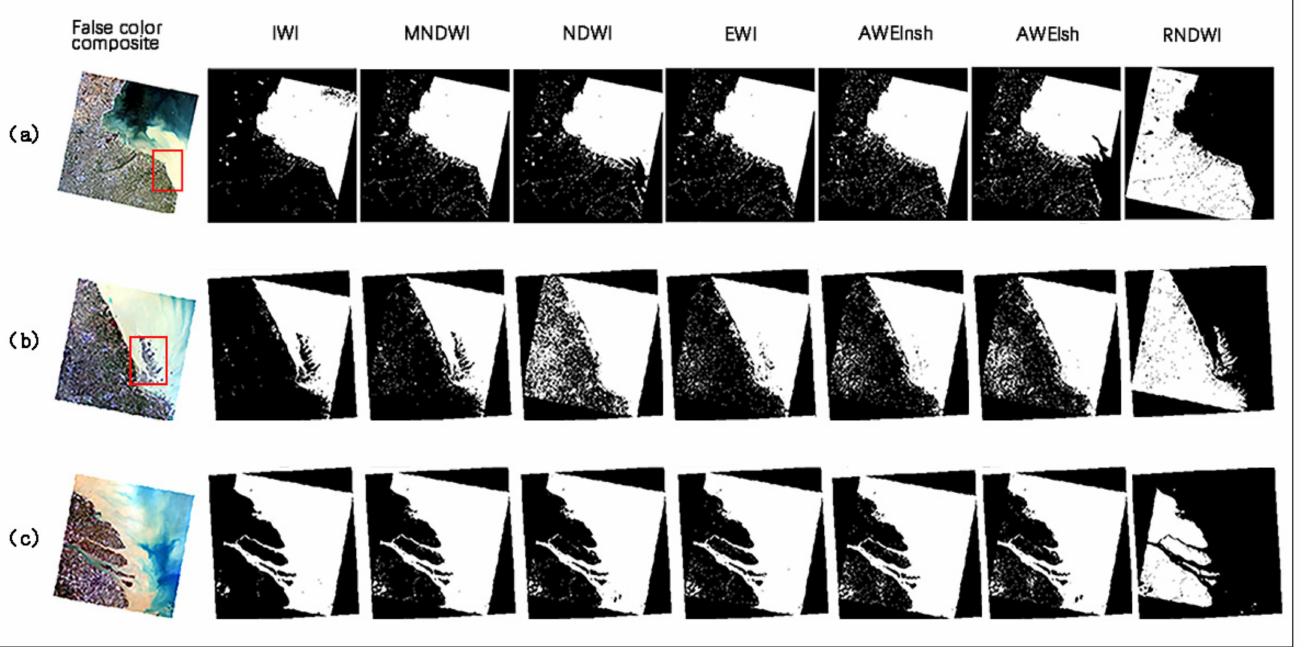
Figure 3. Otsu classification images of each index, whereby the red box in the diagram shows the misclassified areas of the Otsu classification; ( a – c ) correspond to the positions in Figure